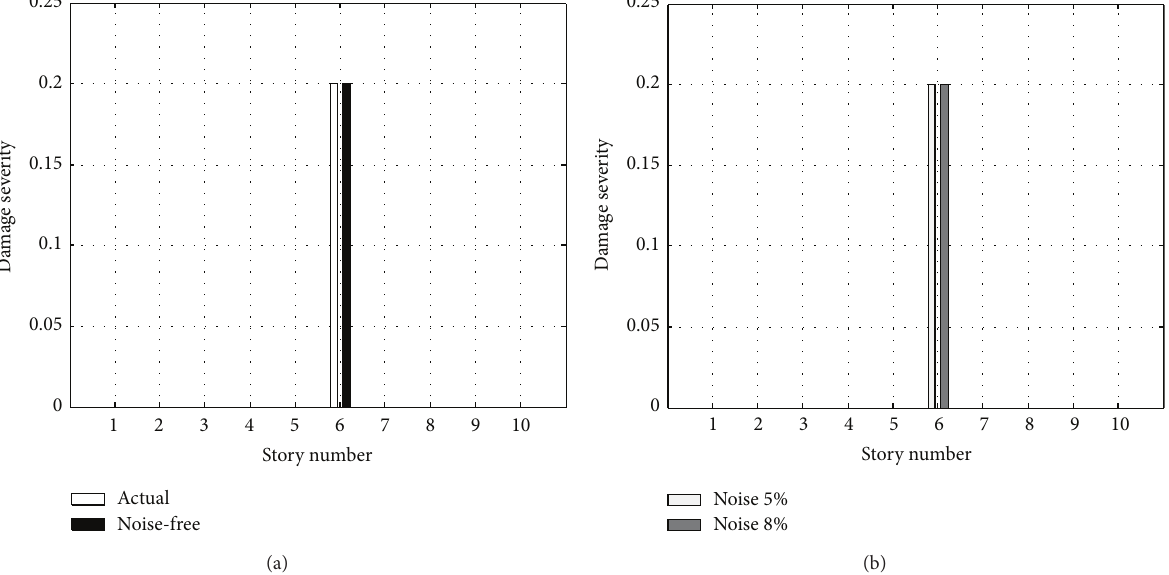
Figure 9: Damage detection results in the ten-story shear frame for scenario